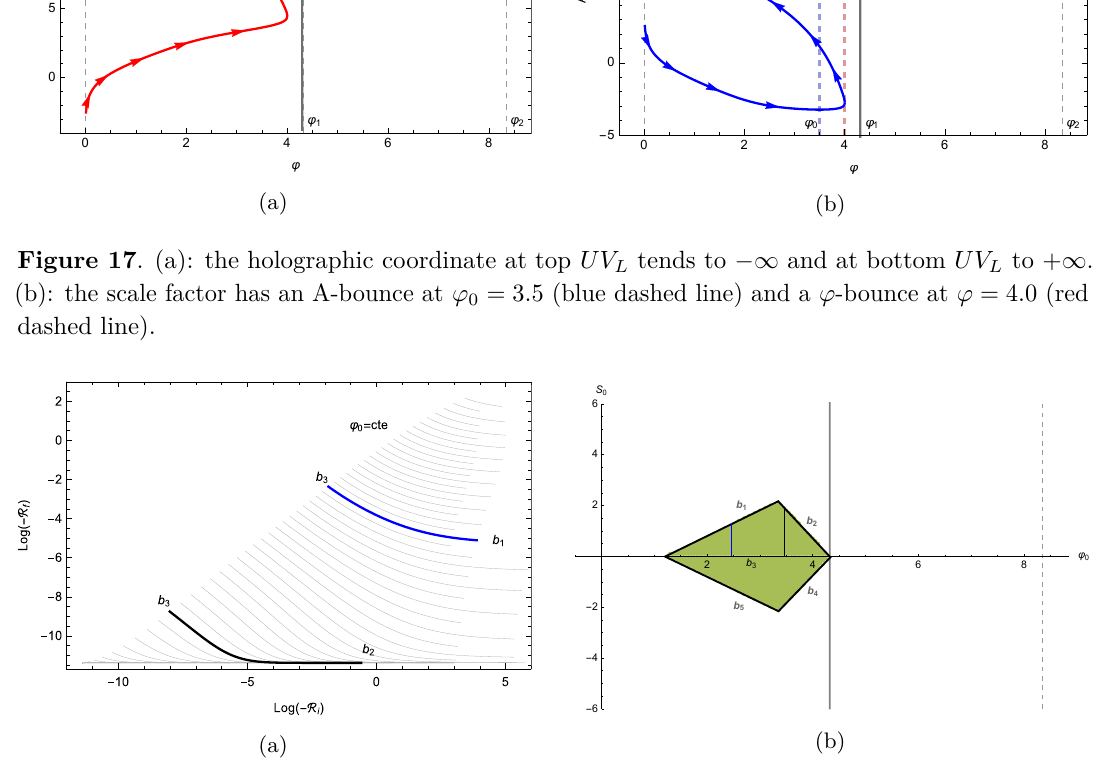
and b , and the black curve is also a typical curve between 1 3